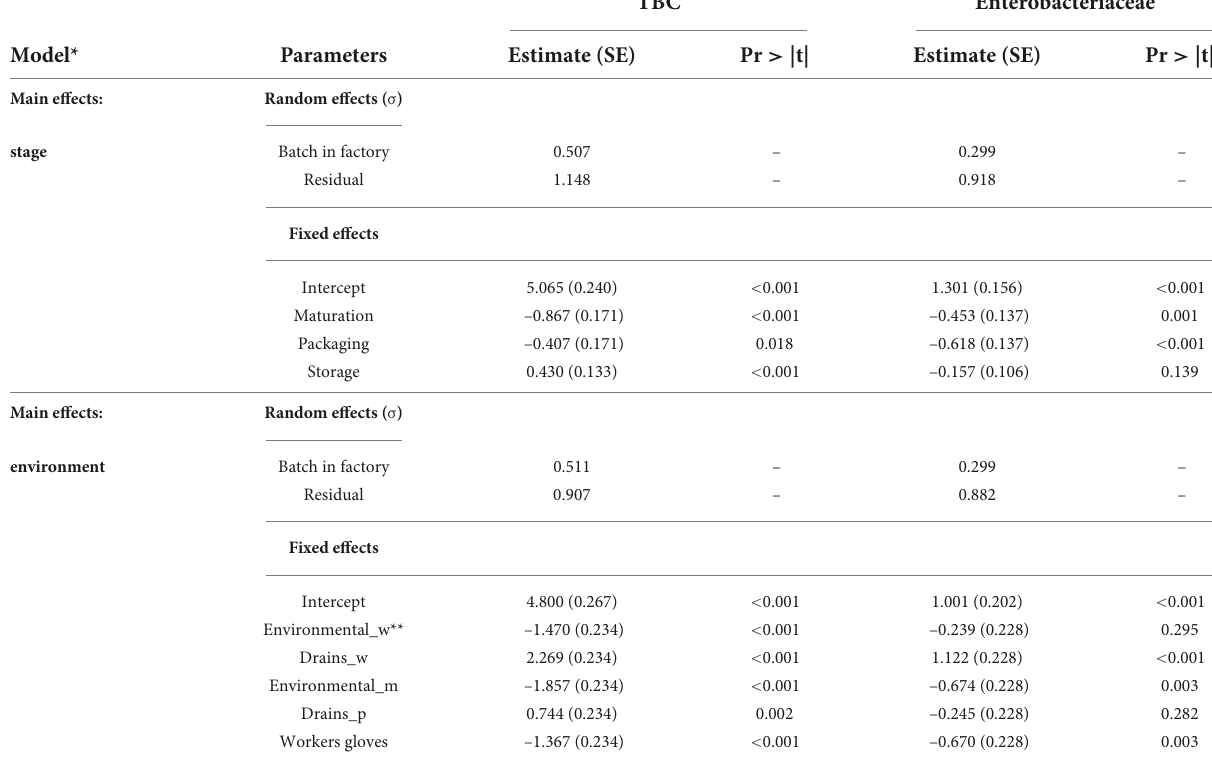
TABLE 4 Parameter estimates of the linear mixed models with random effects assessing the variables “Stage” and “Environment” as main effects on total bacterial counts (TBCs) and Enterobacteriaceae counts in the artisanal soft cheese, as well as estimates of inter-batch